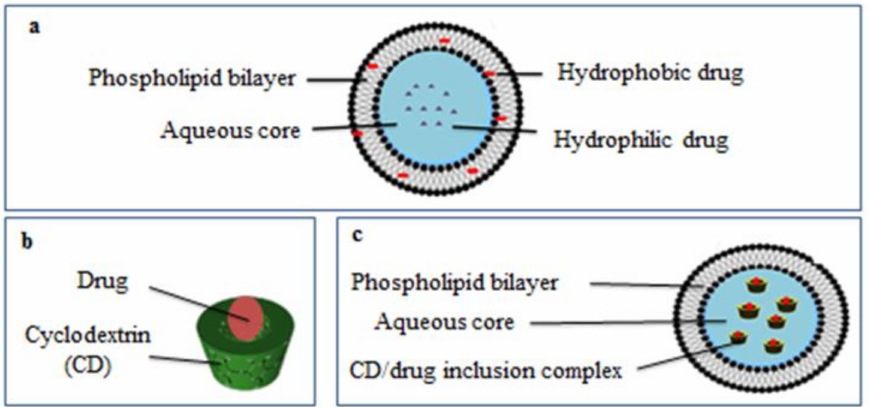
Figure 1. The structure of a liposome ( a ), cyclodextrin/drug inclusion complex ( b ) and drug-in- cyclodextrin-in-liposomes ( c